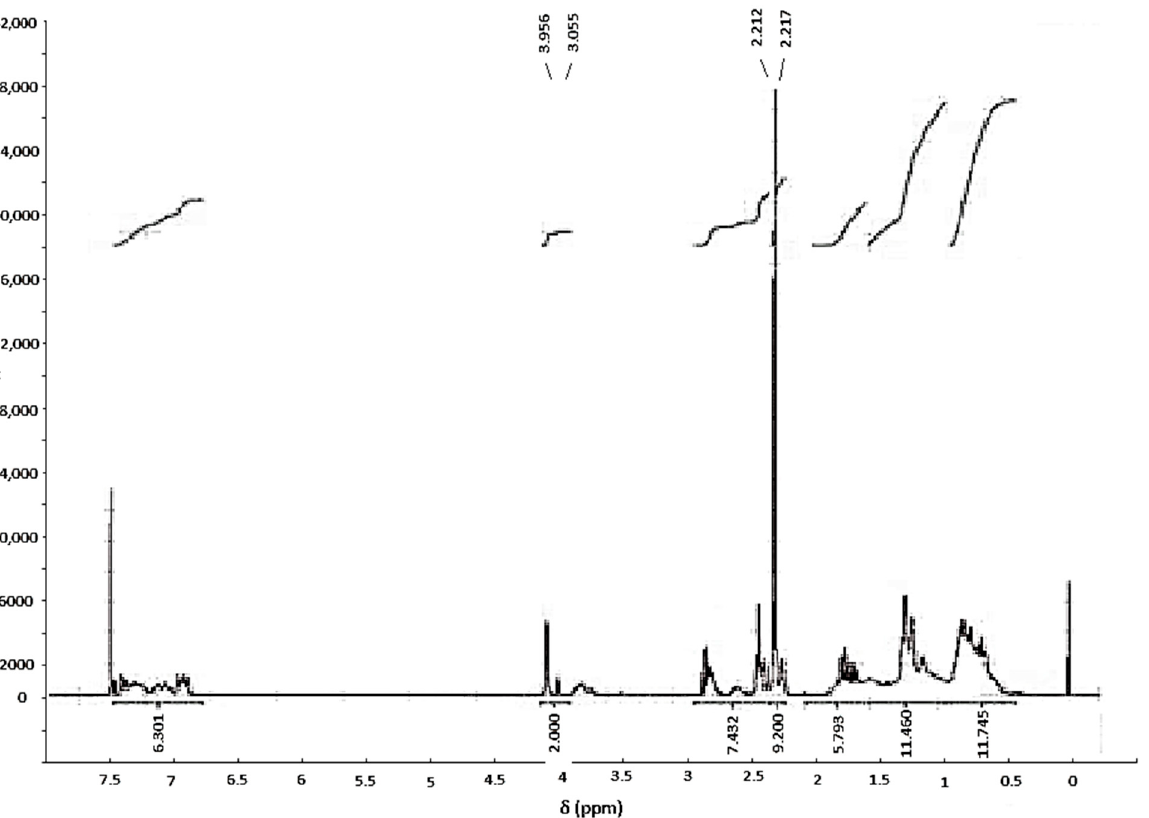
Figure 7. 1 H-NMR spectrum of the DEM2 substance.